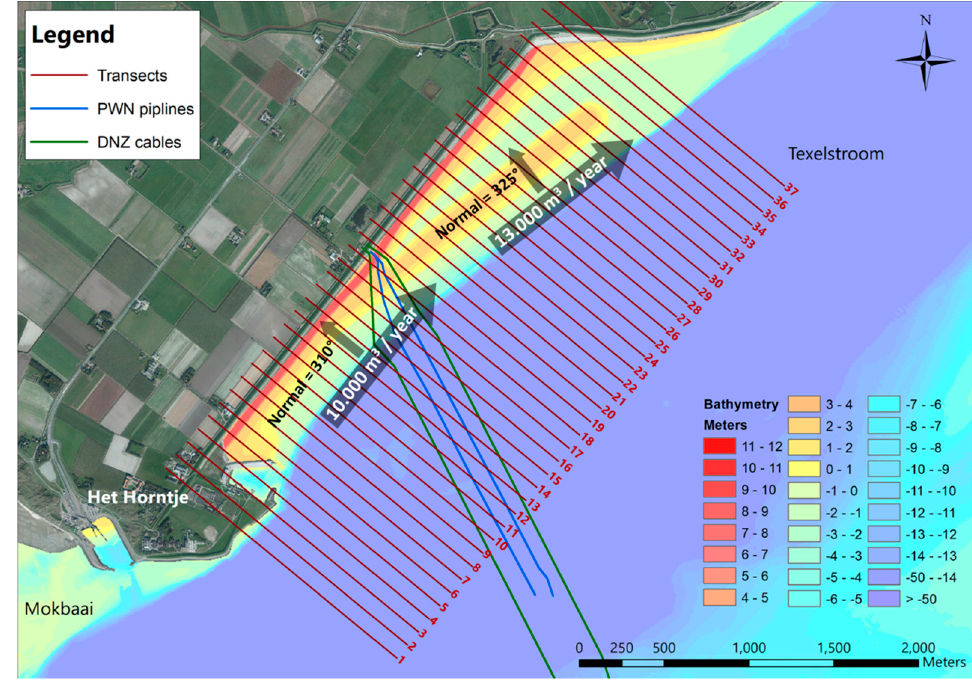
Figure 4. Overview of the project area and transect locations.